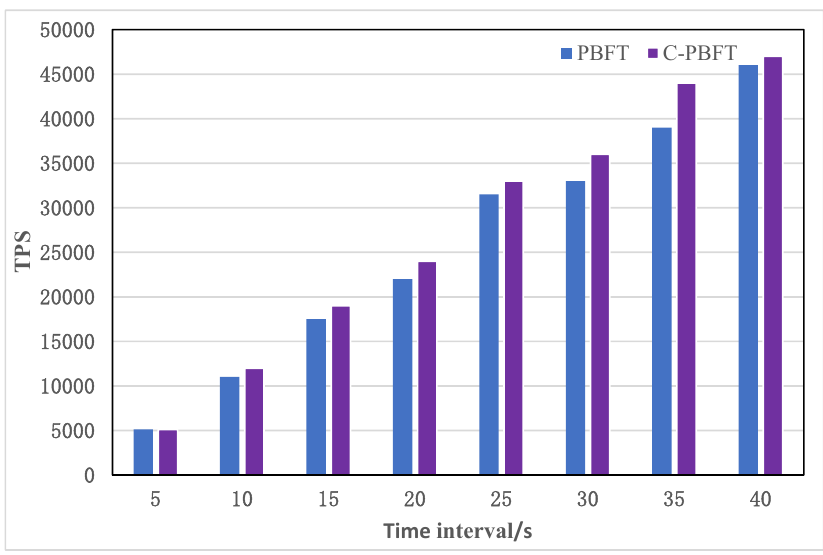
Figure 5. Relationship between time interval and number of transactions.